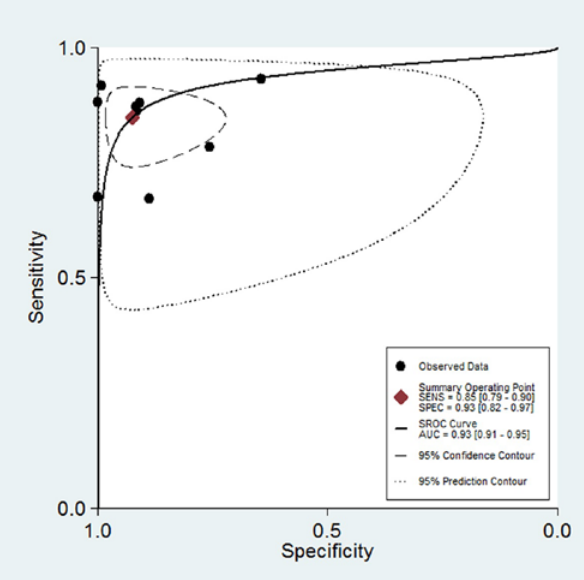
Figure 4: Summary receiver operating characteristic curve. The figure also shows 95% confidence contour and 95%prediction